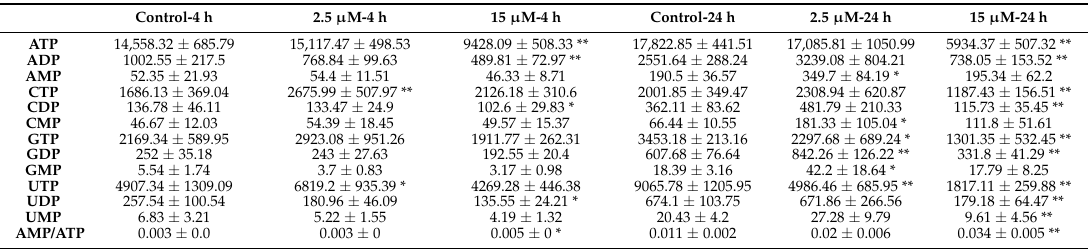
Table 1. Levels of RNs in HL-60 cells before and after incubation with Ara-C (pmol/10 6 cell).